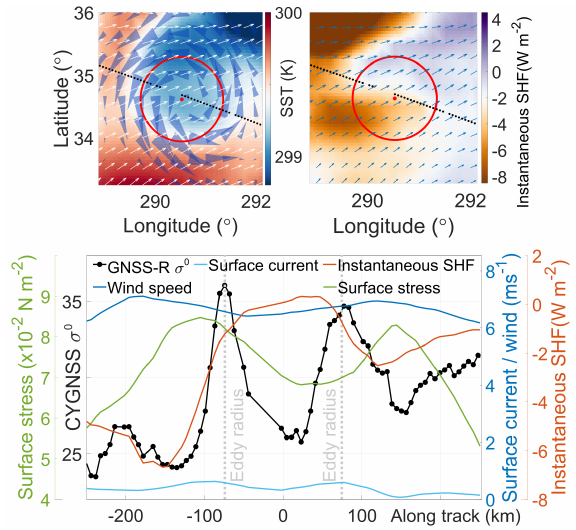
Figure 3. A track of Cyclone GNSS (CYGNSS) overpassing an eddy on 4 July 2017, 12:24. The top-left panel displays sea surface temperature, surface wind (white arrows) and current (blue cones). On the top-right, instantaneous surface sensible heat flux (SHF) as well as surface stress (blue arrows) are visualized. The bottom panel profiles CYGNSS σ 0 along with the wind and current velocity, instantaneous SHF and surface stress magnitudes.